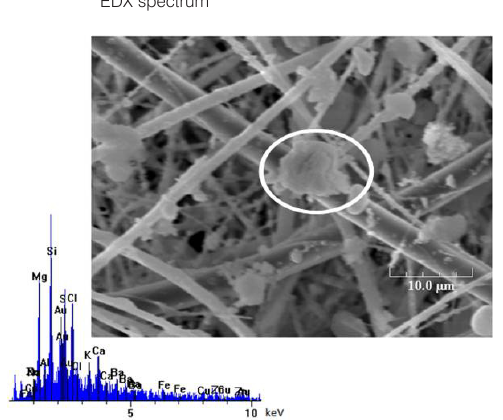
Figure 12. Dust sample from Hillingdon (collected on 28.07.2006): the view of big mineral flake and EDX spectrum